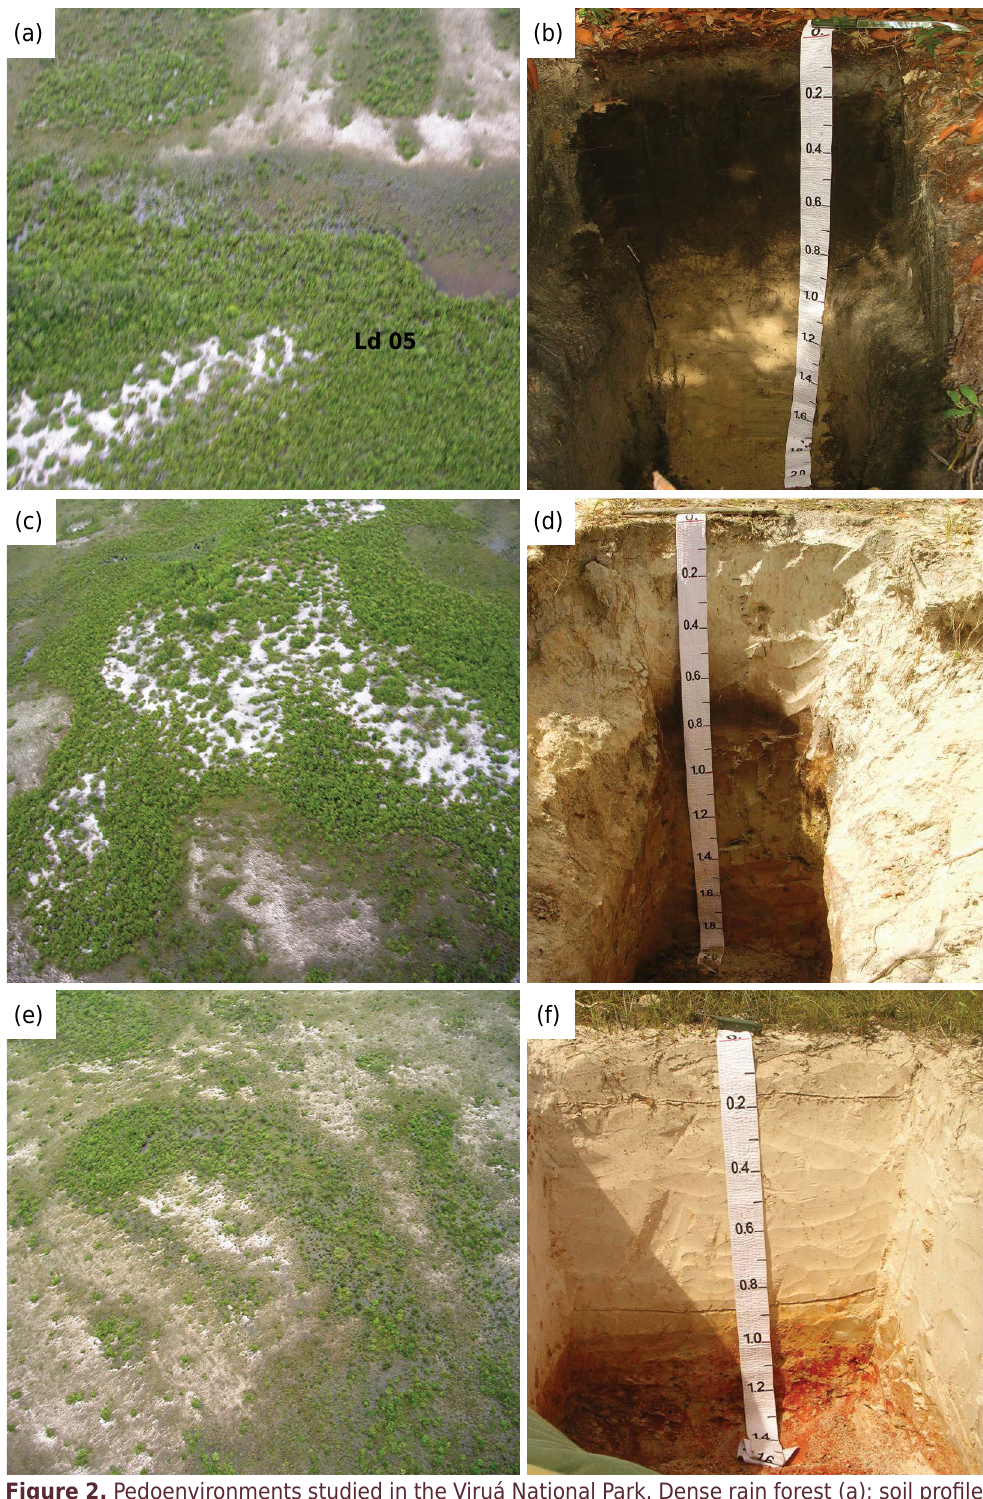
Figure 2. Pedoenvironments studied in the Viruá National Park. Dense rain forest (a); soil profile under dense rain forest – RF1 (b); wooded campinarana – FC1 e FC2 (c); soil profile under wooded campinarana – ASC (d); grassy-woody campinarana – GWC (e); and soil profile under grassy-woody campinarana (f). Photos: José Frutuoso do Vale